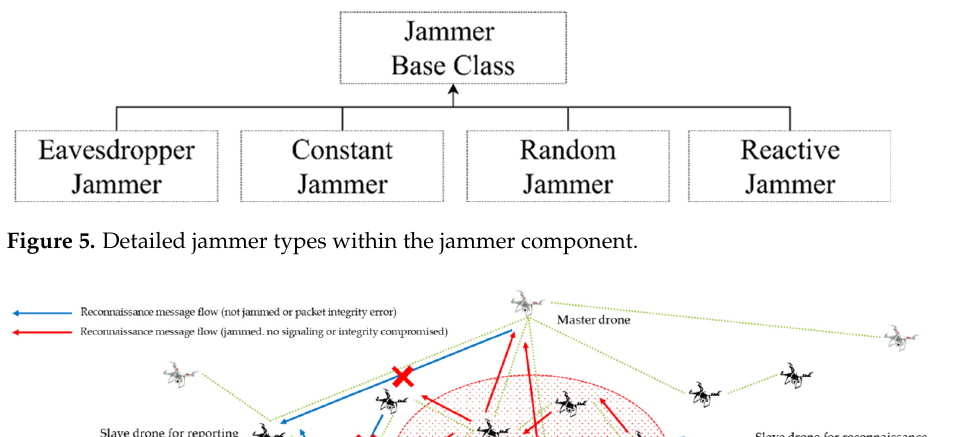
drone maneuvering cation drone maneuvering system.